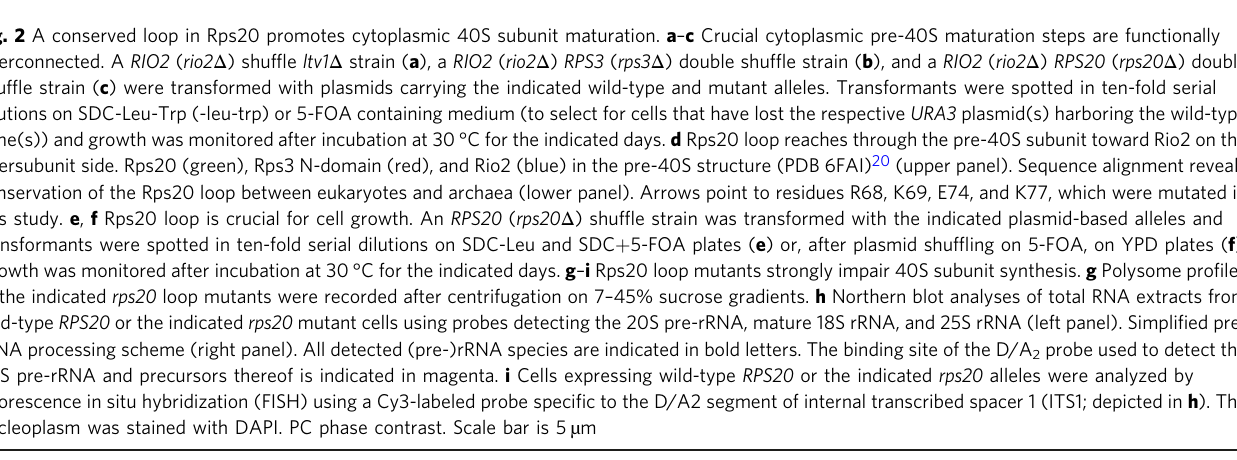
Fig. 2 A conserved loop in Rps20 promotes cytoplasmic 40S subunit maturation. a – c Crucial cytoplasmic pre-40S maturation steps are functionally interconnected. A RIO2 ( rio2 Δ ) shuf fl e ltv1 Δ strain ( a ), a RIO2 ( rio2 Δ ) RPS3 ( rps3 Δ ) double shuf fl e strain ( b ), and a RIO2 ( rio2 Δ ) RPS20 ( rps20 Δ ) double shuf fl e strain ( c ) were transformed with plasmids carrying the indicated wild-type and mutant alleles. Transformants were spotted in ten-fold serial dilutions on SDC-Leu-Trp (-leu-trp) or 5-FOA containing medium (to select for cells that have lost the respective URA3 plasmid(s) harboring the wild-type gene(s)) and growth was monitored after incubation at 30 °C for the indicated days. d Rps20 loop reaches through the pre-40S subunit toward Rio2 on the intersubunit side. Rps20 (green), Rps3 N-domain (red), and Rio2 (blue) in the pre-40S structure (PDB 6FAI) 20 (upper panel). Sequence alignment reveals conservation of the Rps20 loop between eukaryotes and archaea (lower panel). Arrows point to residues R68, K69, E74, and K77, which were mutated in this study. e , f Rps20 loop is crucial for cell growth. An RPS20 ( rps20 Δ ) shuf fl e strain was transformed with the indicated plasmid-based alleles and transformants were spotted in ten-fold serial dilutions on SDC-Leu and SDC + 5-FOA plates ( e ) or, after plasmid shuf fl ing on 5-FOA, on YPD plates ( f ). Growth was monitored after incubation at 30 °C for the indicated days. g – i Rps20 loop mutants strongly impair 40S subunit synthesis. g Polysome pro fi les of the indicated rps20 loop mutants were recorded after centrifugation on 7 – 45% sucrose gradients. h Northern blot analyses of total RNA extracts from wild-type RPS20 or the indicated rps20 mutant cells using probes detecting the 20S pre-rRNA, mature 18S rRNA, and 25S rRNA (left panel). Simpli fi ed pre- rRNA processing scheme (right panel). All detected (pre-)rRNA species are indicated in bold letters. The binding site of the D/A 2 probe used to detect the 20S pre-rRNA and precursors thereof is indicated in magenta. i Cells expressing wild-type RPS20 or the indicated rps20 alleles were analyzed by fl uorescence in situ hybridization (FISH) using a Cy3-labeled probe speci fi c to the D/A2 segment of internal transcribed spacer 1 (ITS1; depicted in h ). The nucleoplasm was stained with DAPI. PC phase contrast. Scale bar is 5 µ